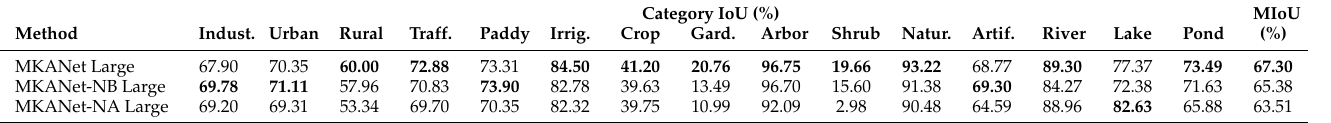
Table 9. Comparison of MKANets with and without auxiliary losses on the GID Fine Land Cover Classification